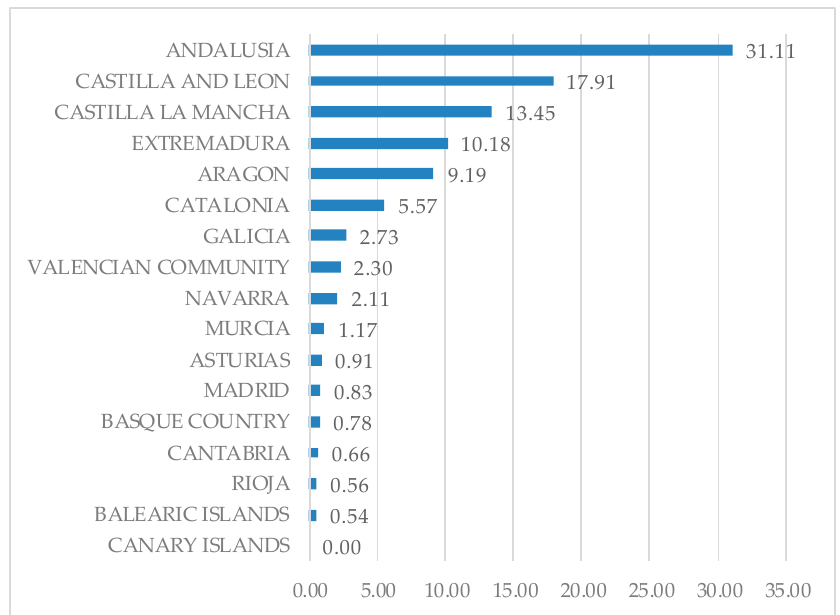
Figure 5. Percentage distribution of the EAGF for the period 2014–2020 (Source: Own elaboration from data published by the Ministry of Agriculture, Fisheries and Food).